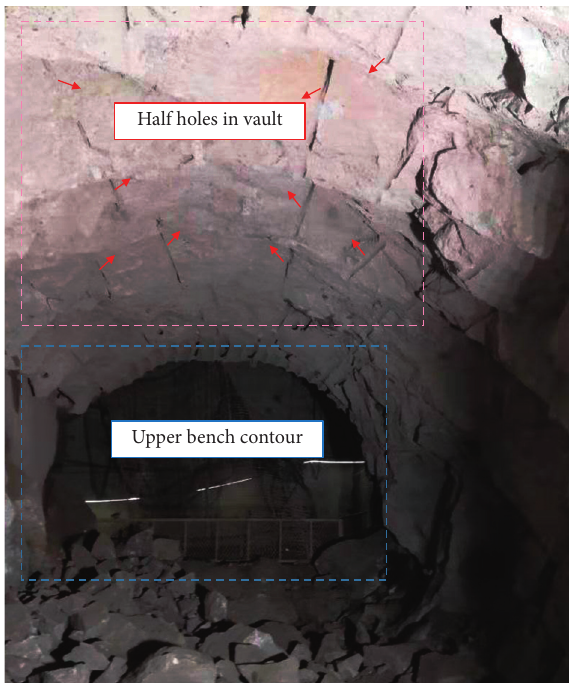
Figure 14: Smooth rock fracturing